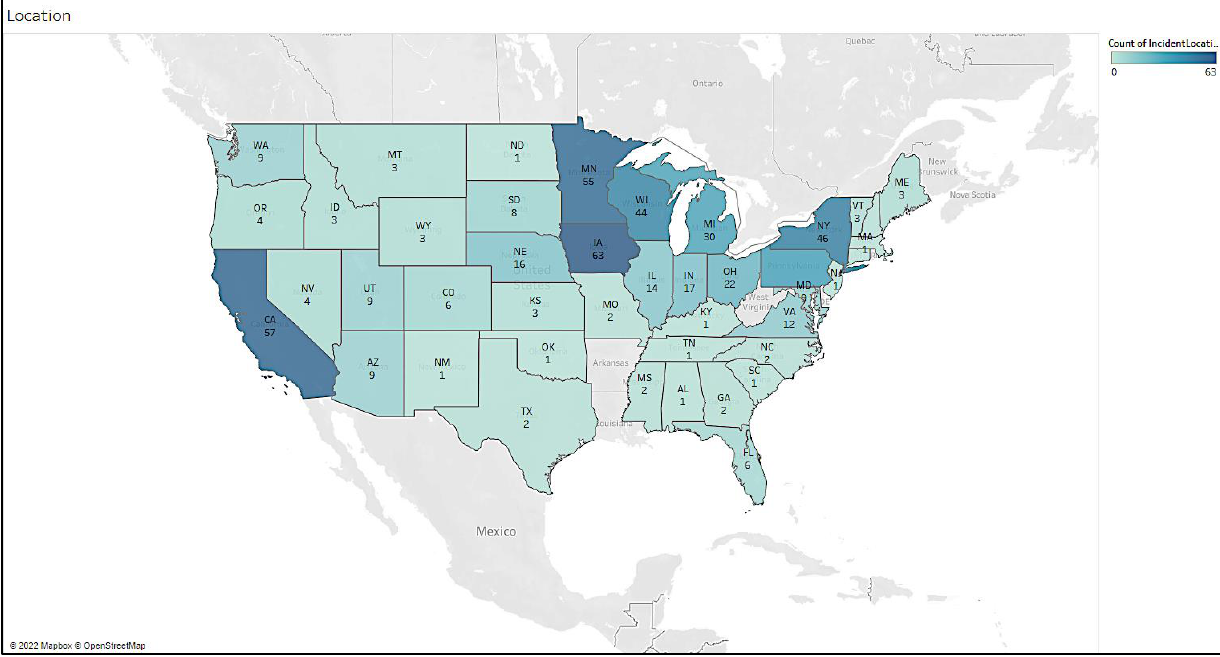
Figure 7. Dashboard software display map with case count.